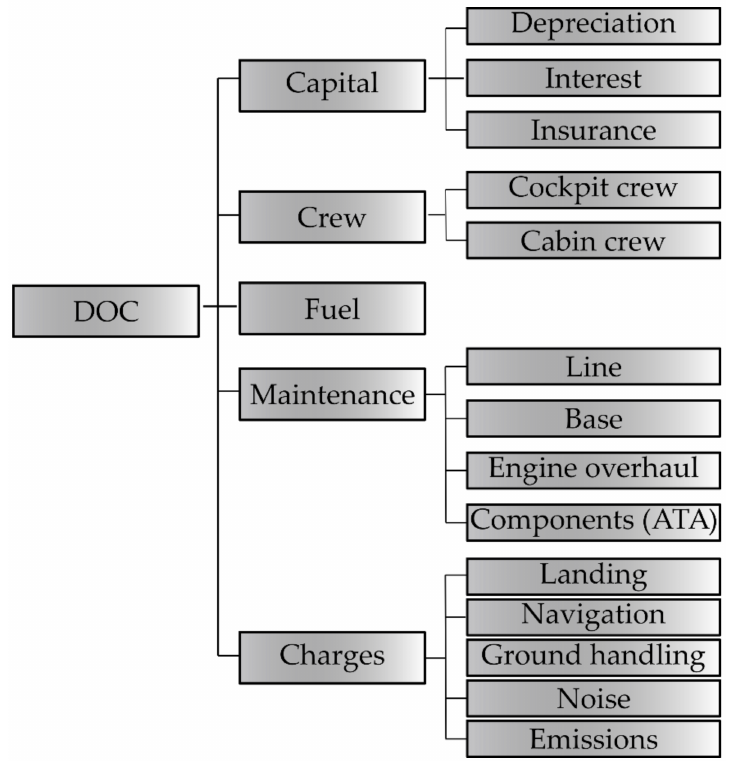
Figure 1. DOC breakdown.